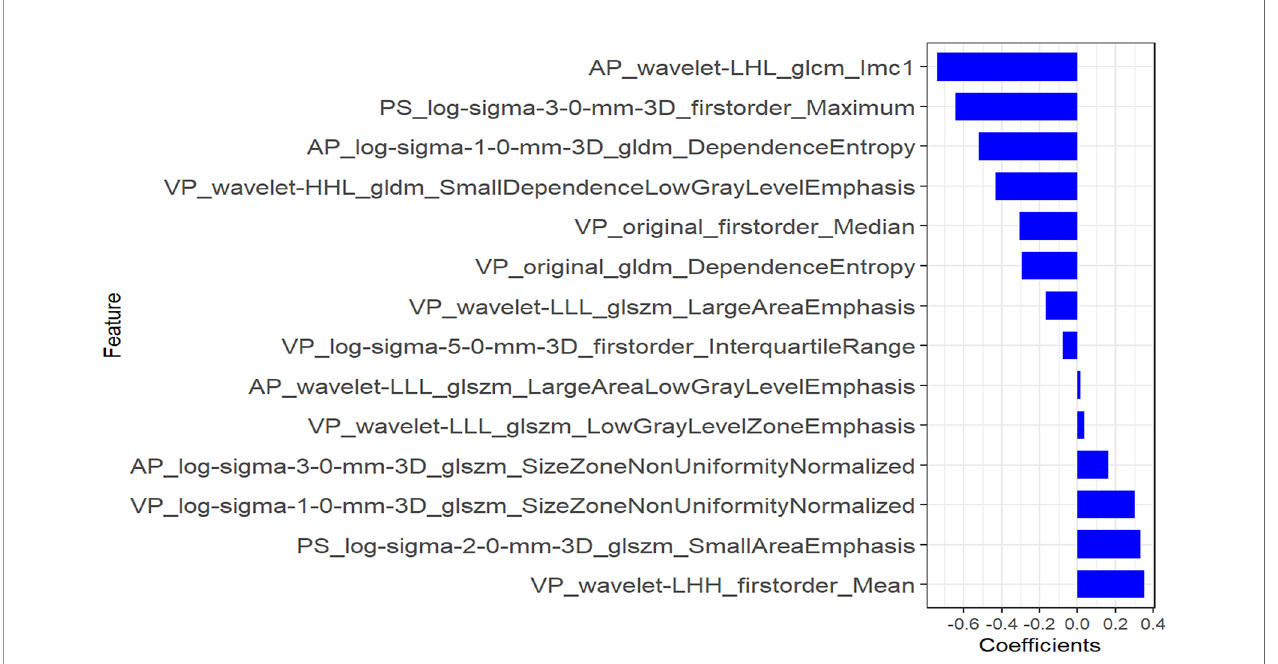
FIGURE 3 | Features selected for multi-phase radiomics model